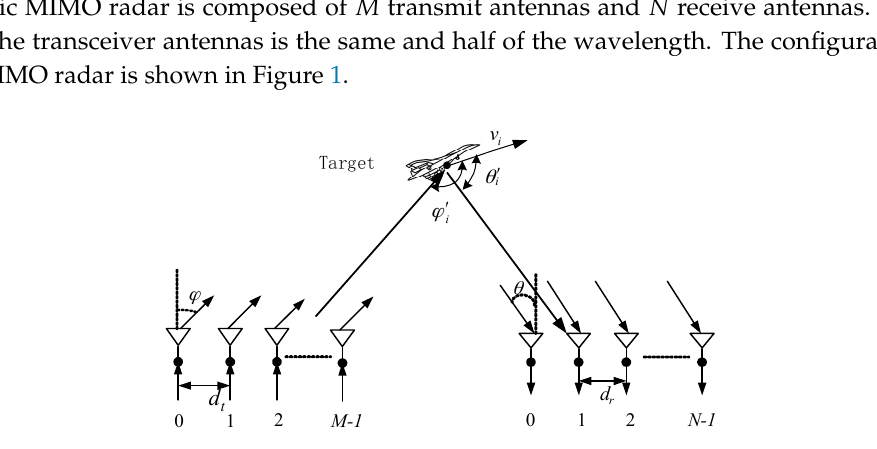
Figure 1. Bistatic multiple-input multiple-output (MIMO) radar transceiver element configuration.